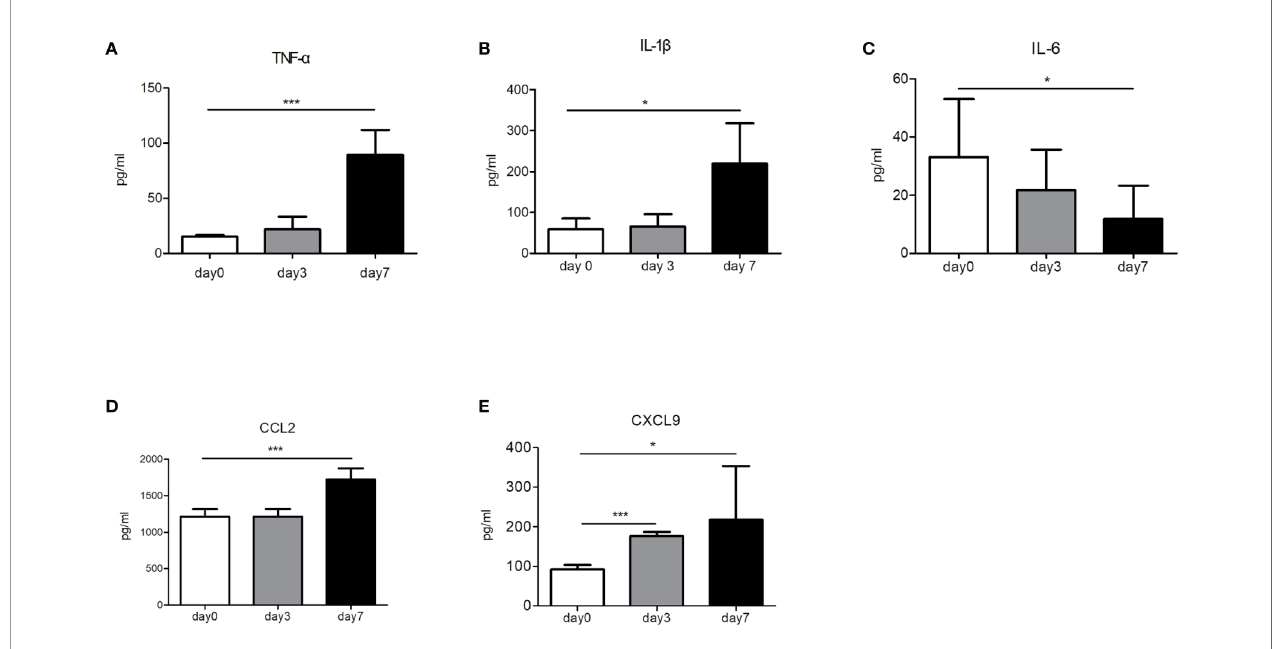
FIGURE 7 | The concentrations of immune cytokines and chemokines before and after nsPEFs treatment. (A) Expression levels of TNF- a in the blood. (B) Expression levels of IL-1 b in the blood. (C) Expression levels of IL-6 in the blood. (D) Expression levels of CCL2 in the tumor. (E) Expression levels of CXCL9 in the tumor. Data are presented as the mean ± SD. P-values were calculated based on a Student ’ s t-test (n>3 independent experiments). * p < 0.05, *** p <